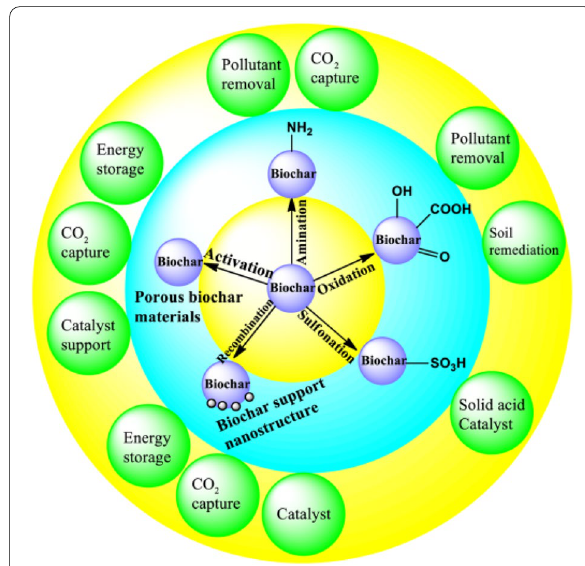
Fig. 1 Demonstration of biochar as a platform carbon material for the synthesis of functional materials and their potential applications (Liu et al.